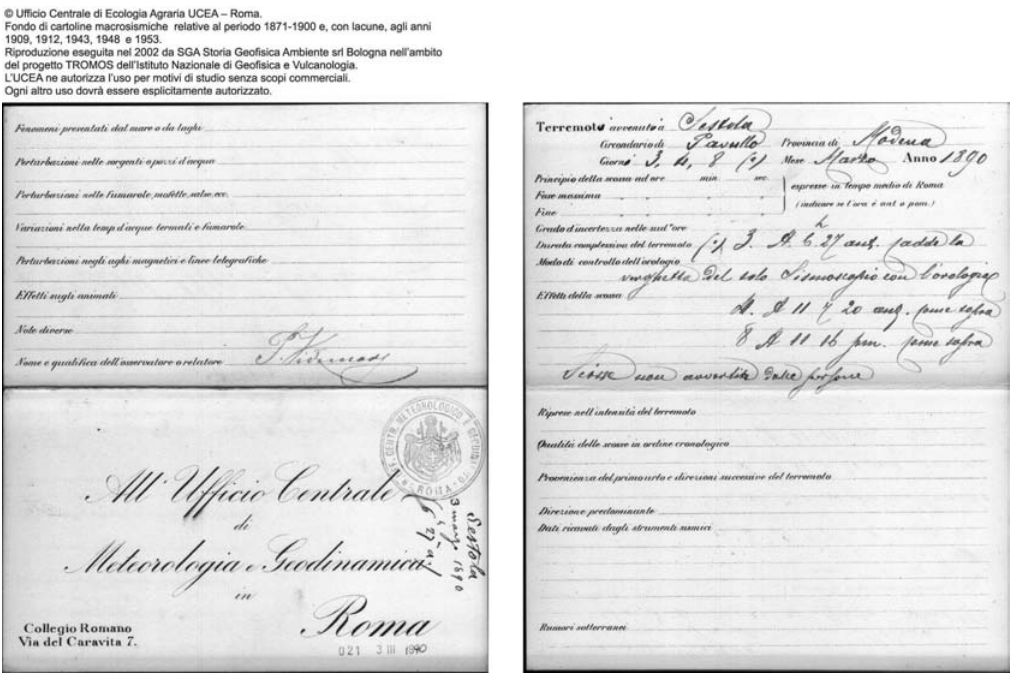
Fig. 19. Example of PDF file with the front and back images of a macroseismic questionnaire. The heading re- ports the institution owning the documents, the institution promoting the reproduction and the use of the docu- mentation